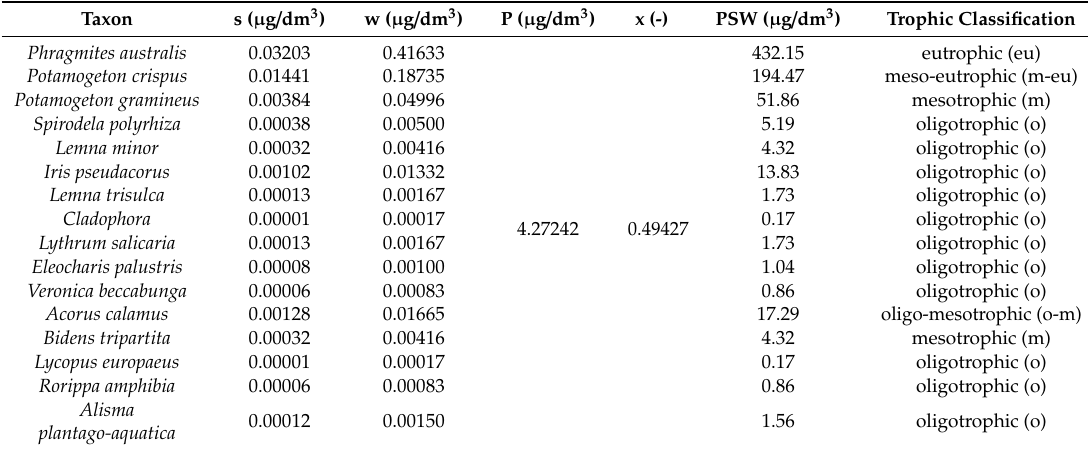
Table 12. Summary of the Trophic Index of Macrophytes (TIM) results, May 2017, reference section on the ´Sl˛eza.